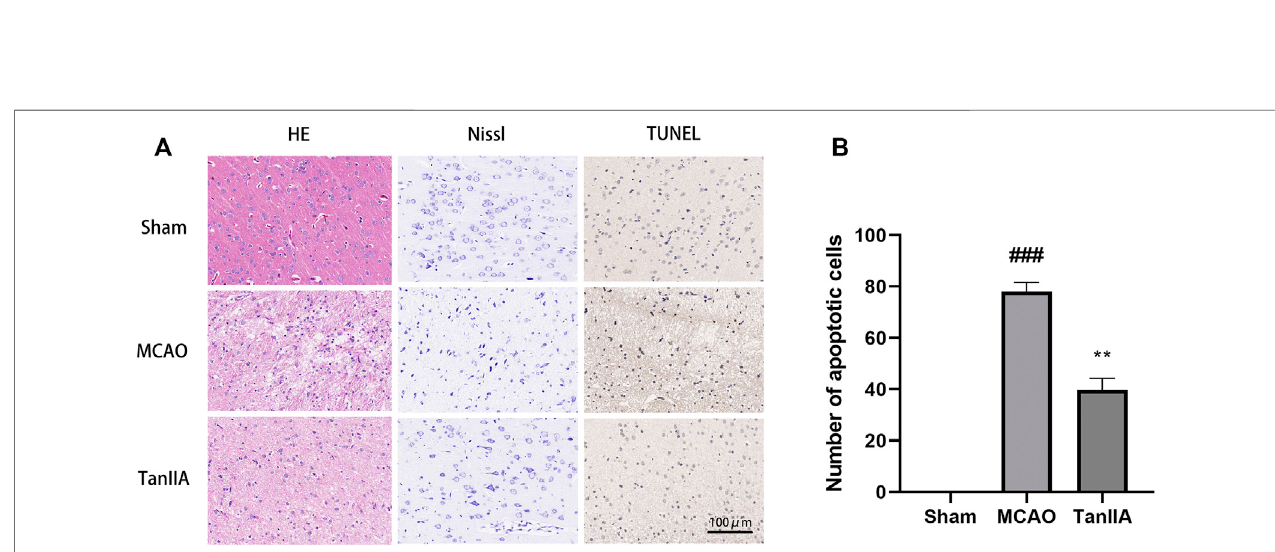
FIGURE 3 | Effects of Tanshinone IIA on pathology and apoptosis after MCAO in rat brains. Tanshinone IIA or control saline was injected into the tail vein at the indicated time after MCAO. After reperfusion, the rat brains were harvested. (A) Pathological changes of rat cortex tissues were detected by HE staining and Nissl staining, apoptotic cells in rat cortex were detected by TUNEL staining (Scale bar: 100 μ m). (B) The apoptotic cells of different groups were calculated and shown. ### p < 0.001, compared with the Sham group, ** p < 0.01, compared with the MCAO group. Sham, sham operation group; MCAO, middle cerebral artery occlusion; TanIIA, Tanshinone IIA, n (cid:1) 3.